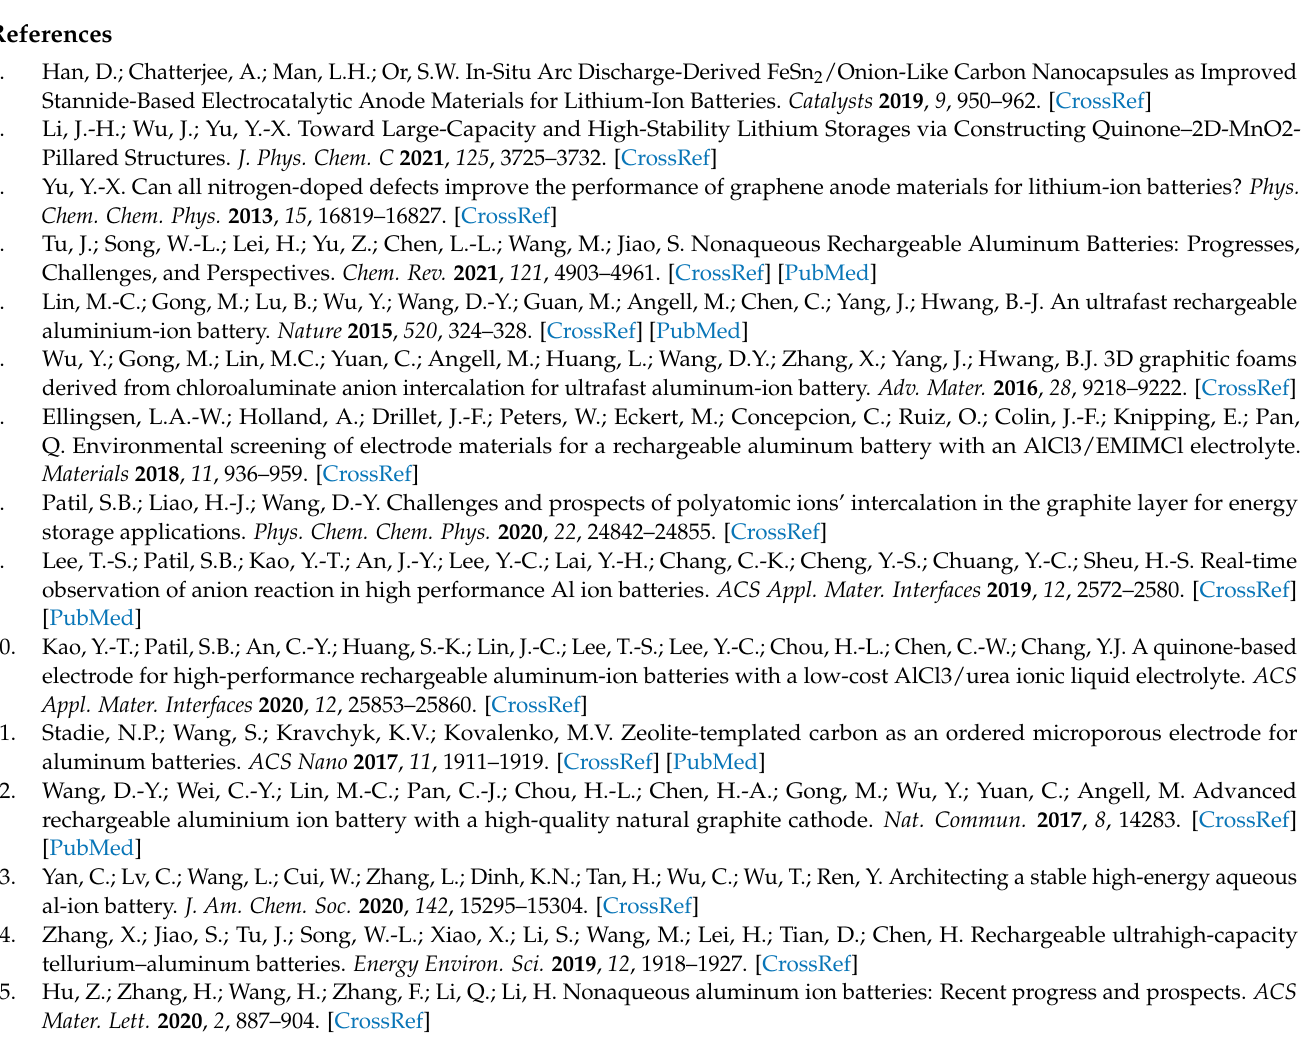
capability of 1T-MoS2-urea at 60 ◦ C, Table S1: A comparison table comprising of different cathodes, Figure S3: Charge-discharge profile and cycling performance of SP-1-EMIC at 60 ◦ C, Figure S4: XRD patterns of 1T-MoS2/SP-1 before and after